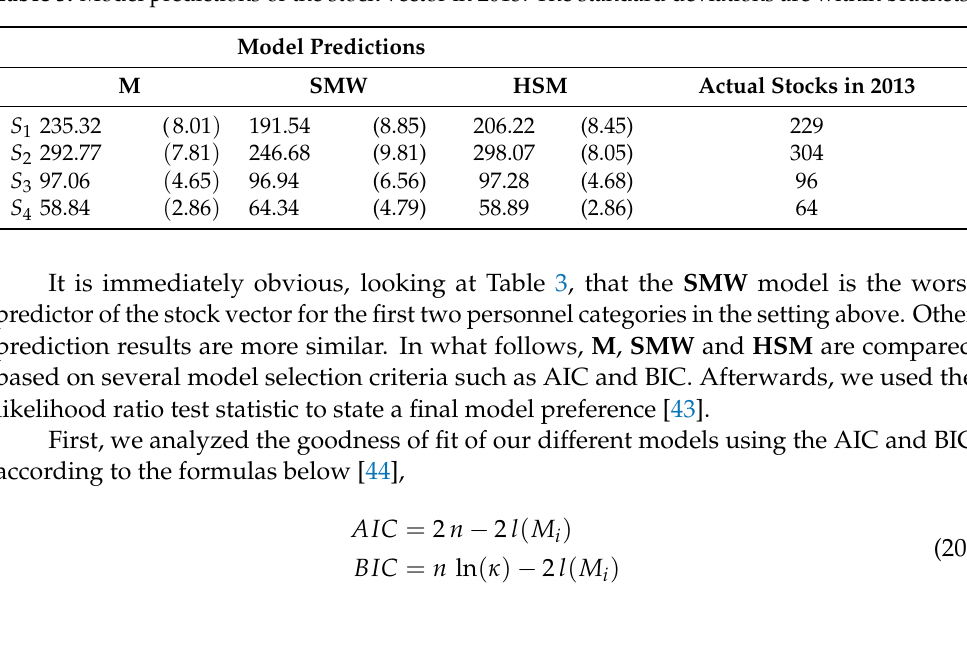
Table 3. Model predictions of the stock vector in 2013. The standard deviations are within